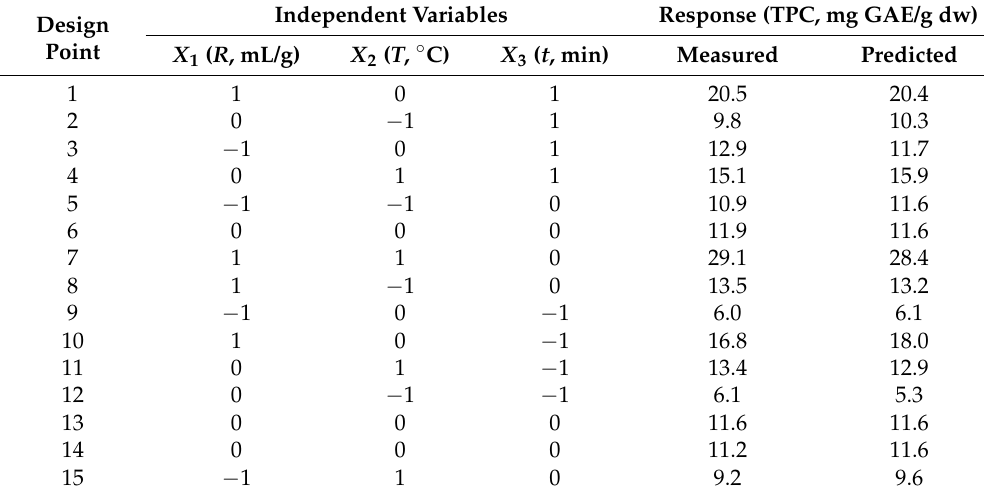
Table 3. The design points included in the experimental design, the corresponding coded values of the process variables, and the TPC values for the measured and predicted responses were optimized for APW extraction with